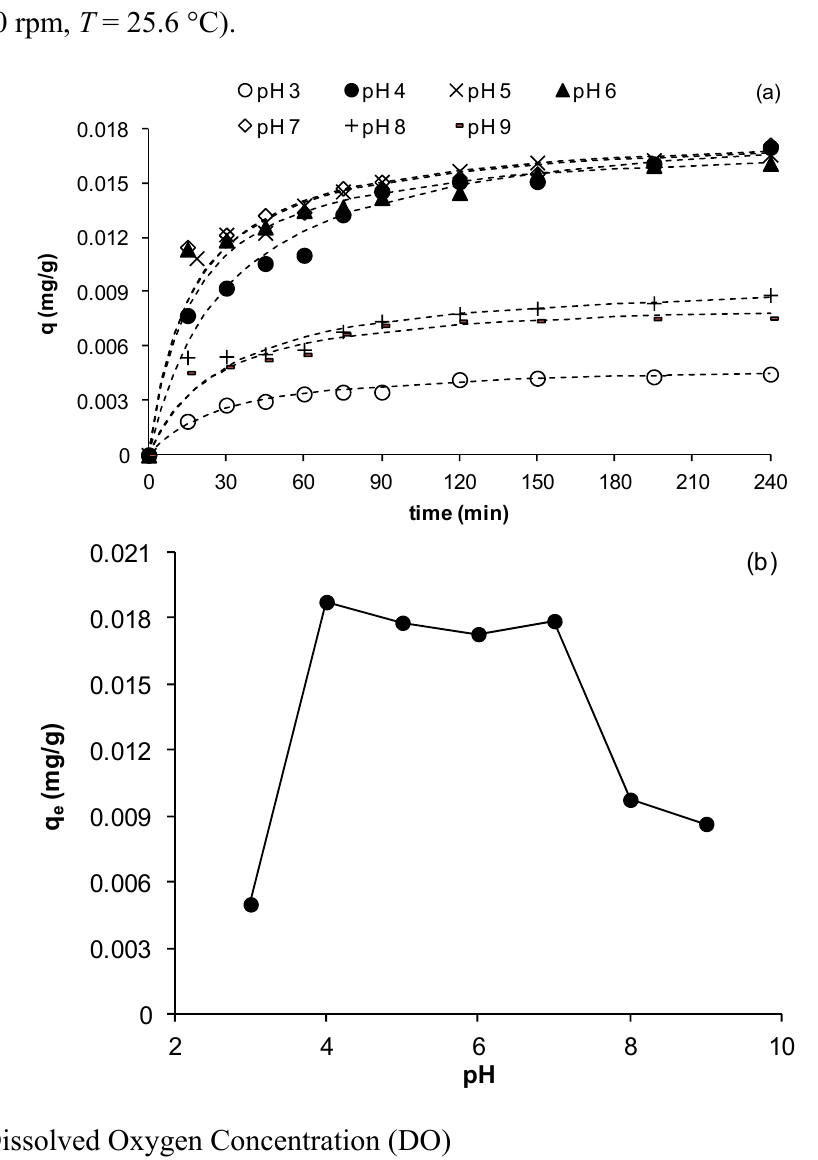
e = 50 g, C = 23 mg/L, V = 50 mL, shaker sand 0 solution